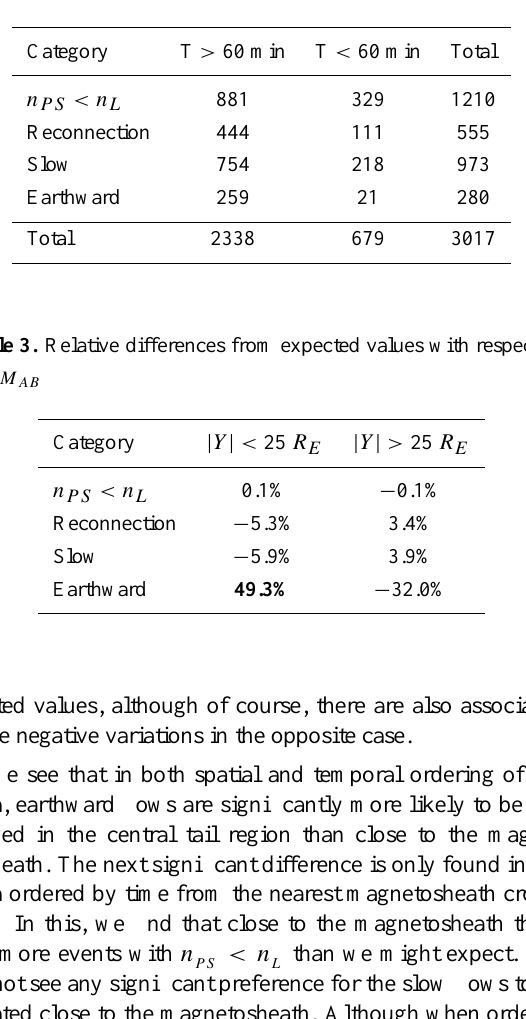
Table 1. Distribution of plasma sheet encounters with respect to Table 2. Distribution of plasma sheet encounters sorted by time